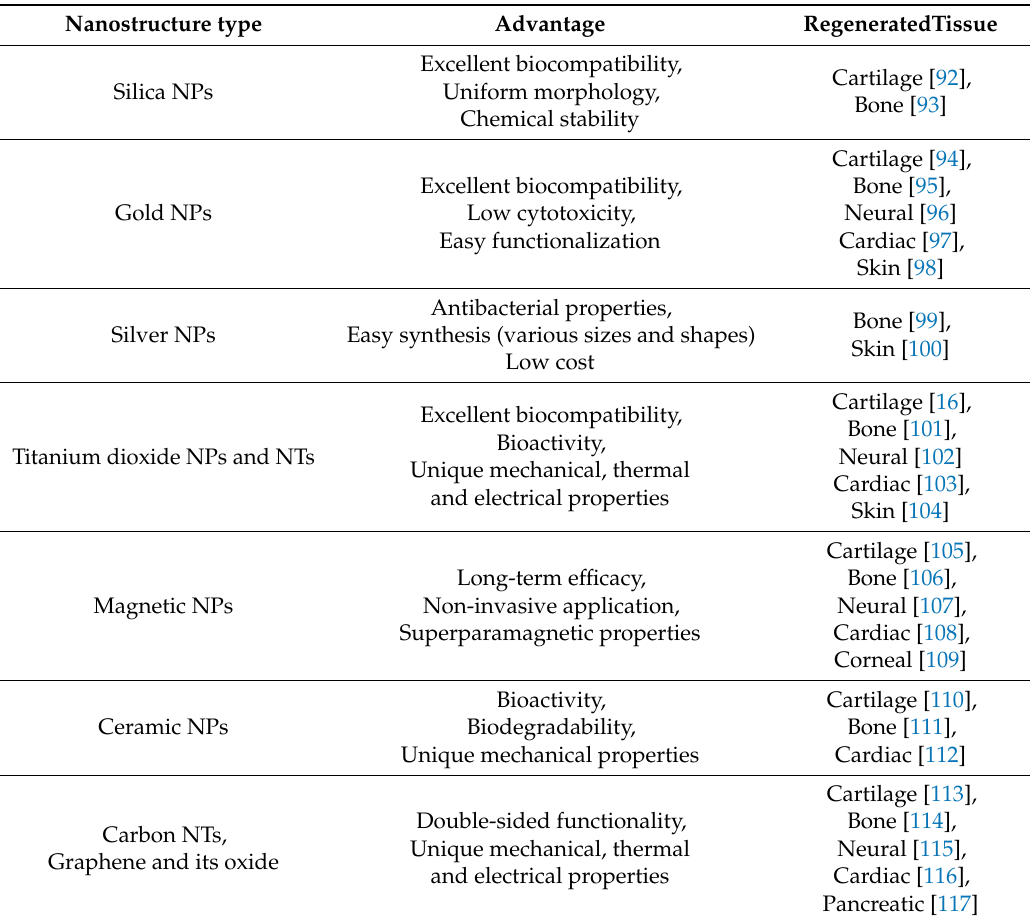
Table 2. Overview of tissue engineering applications of inorganic nanomaterials and their main